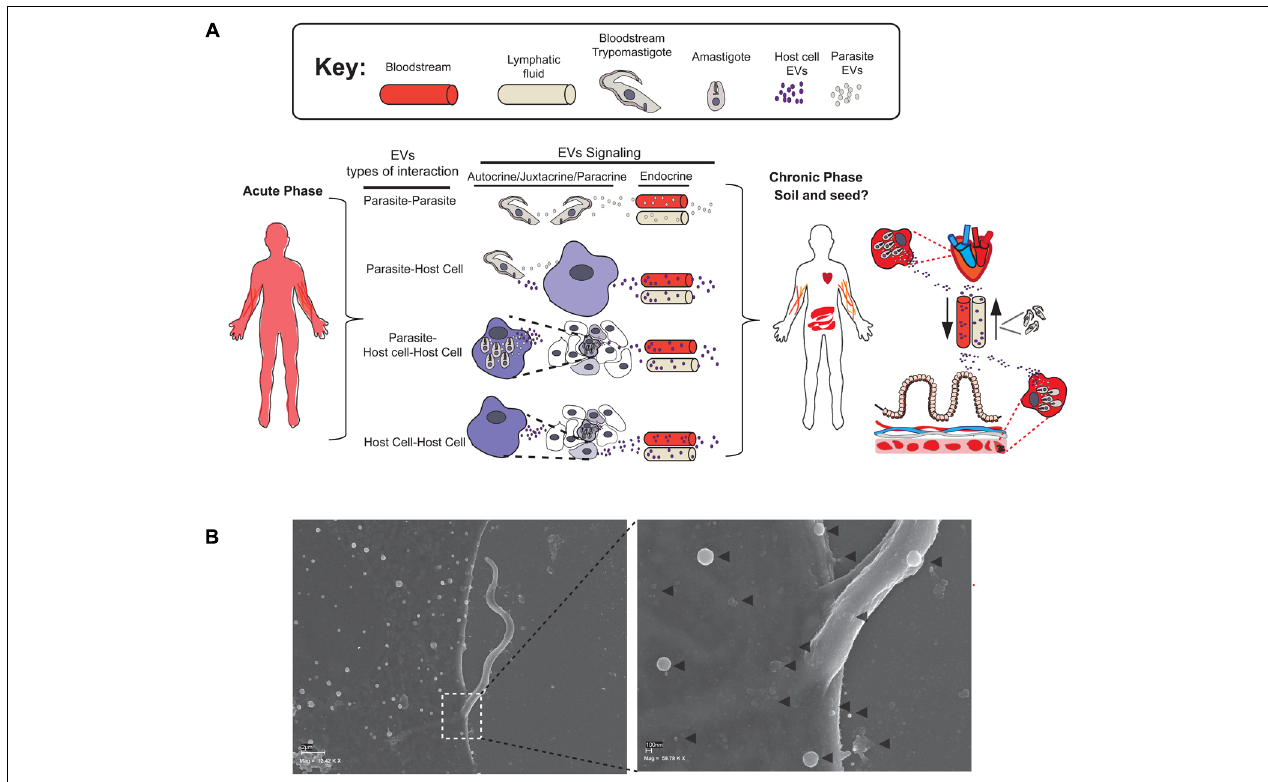
FIGURE 2 | Types of EV transfer and interaction in acute and chronic phases of Chagas disease. (A) EVs could be released by Trypomastigote or Amastigote forms during Acute and/or Chronic phase of the disease. This secretion could be mediated between parasites, parasites and its host cells or between infected and uninfected cells mediating Autocrine, Yuxtacrine, or Paracrine type of signaling. EVs could be also released to the bloodstream or lymphatic fluids for distant endocrine targeting. During Chronic phase endocrine signaling may mediate changes for tissue re-education, colonization, and further inflammation. (B) Scanning electron microscopy of a MT invading a host cell. The right figure shows a magnified image of the MT point of contact with the host cell membrane. The gray arrows indicate the EVs of different sizes that may derive from both parasite and host cell. This picture corresponds to an infection of Vero Cells with MTs (strain PAN4 DTU Ia) for 2 h and belongs to the same series of scanning microscopic pictures published in Díaz Lozano et al.